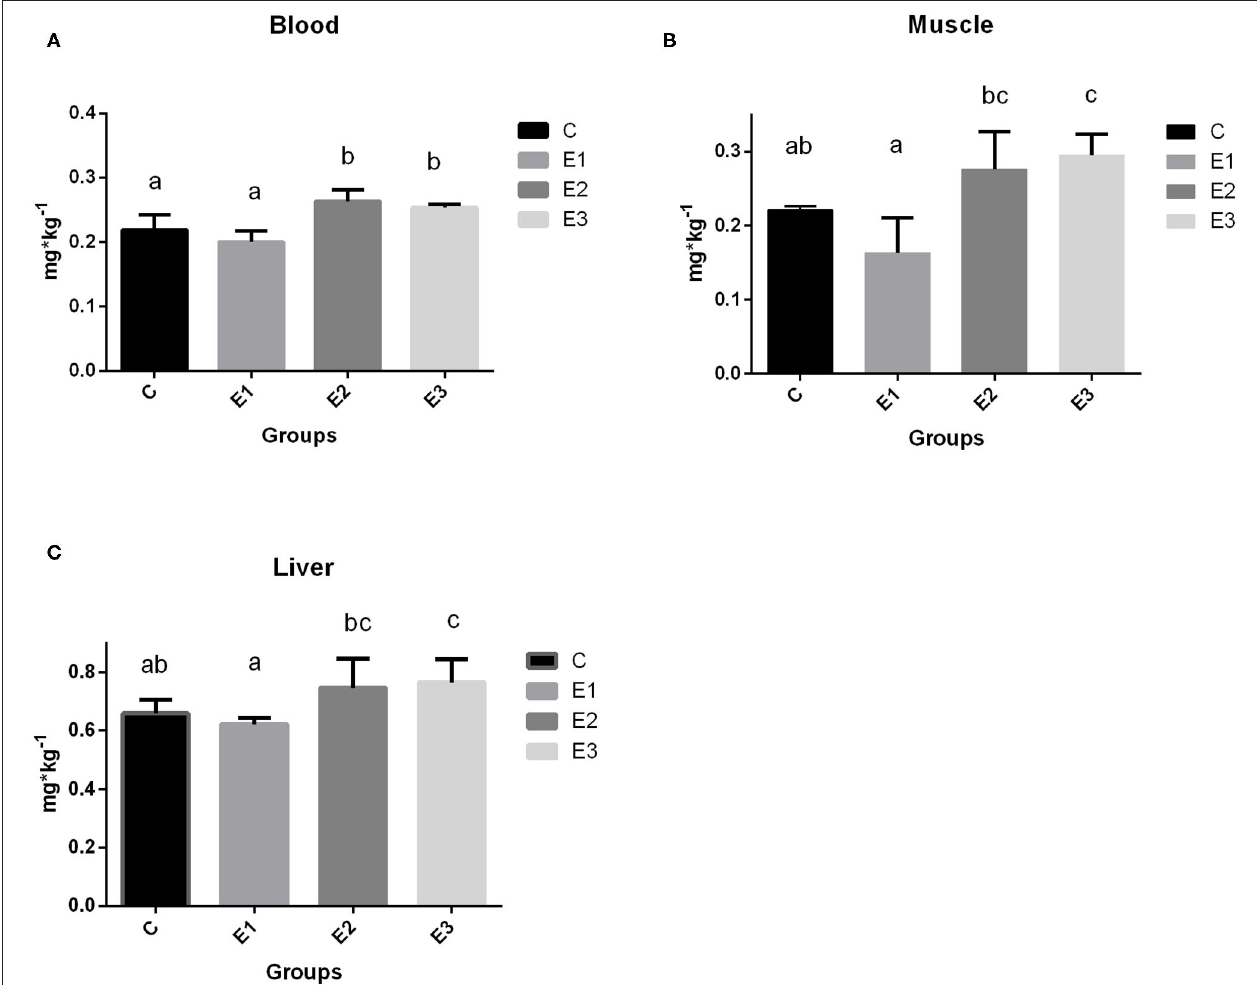
FIGURE 1 | Selenium concentration in blood (A) , muscle (B) , and liver (C) tissue of growing pigs fed with different sources and concentrations of selenium; C-0.3 mg/kg DM organic Se, E1-0.5 mg/kg DM inorganic Se, E2-0.5 mg/kg DM organic Se; E3-0.5 mg/kg DM organic Se + 0.2% zeolite clinoptilolite. Values are means ± SEM. Bars with different superscript letters (a, b, c) were different, P <